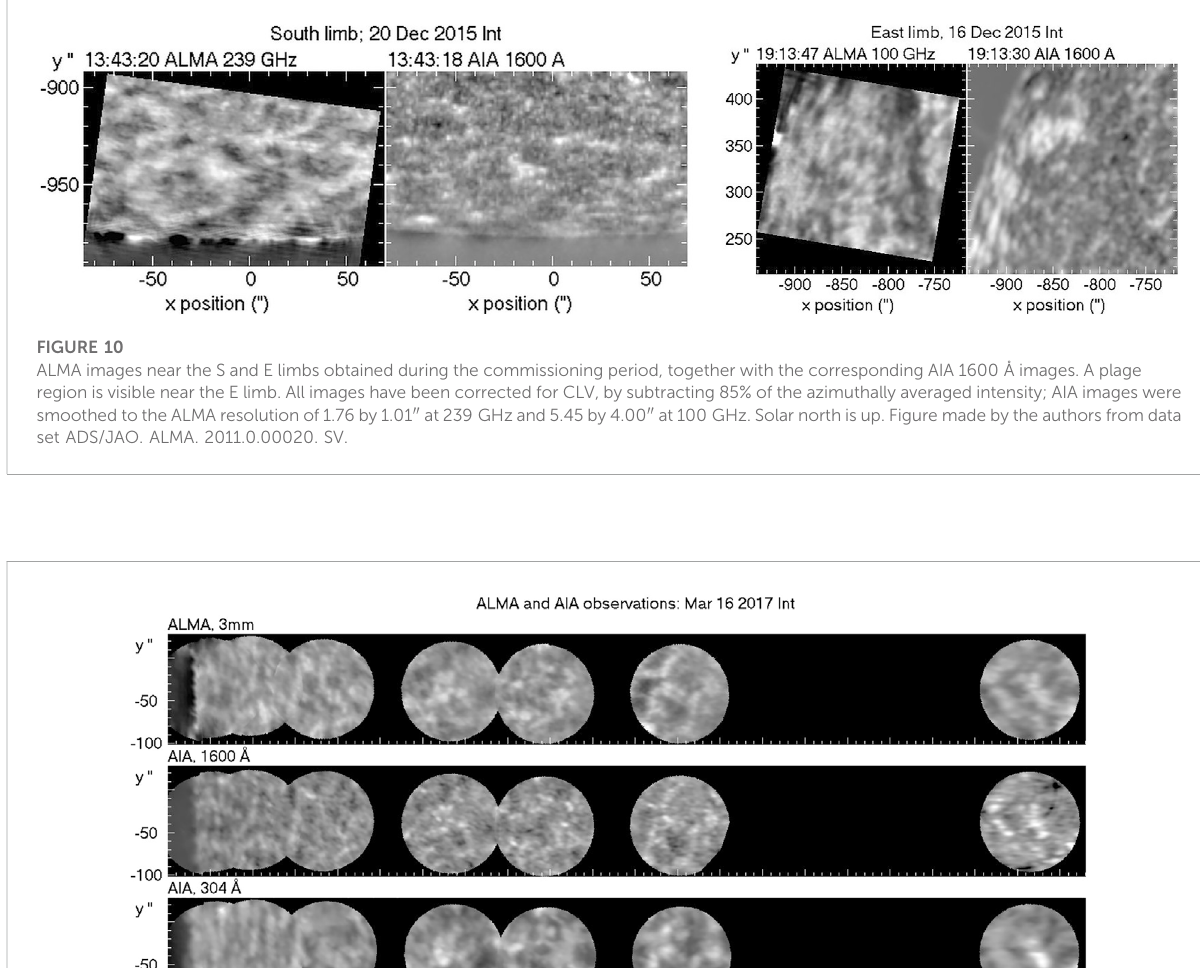
Figure 12 reveals a similarity with negative, broadband, H α images from the GONG network. A similar association of ALMA and H α features was reported by Alissandrakis et al. (2022) from full-disk 347 MHz (0.85 mm) images. Nindos et al. (2021) attributed this similarity in terms of absorption in H α by dark mottles (spicules), located above network elements, implying that the mottles are transparent at 3 mm and that